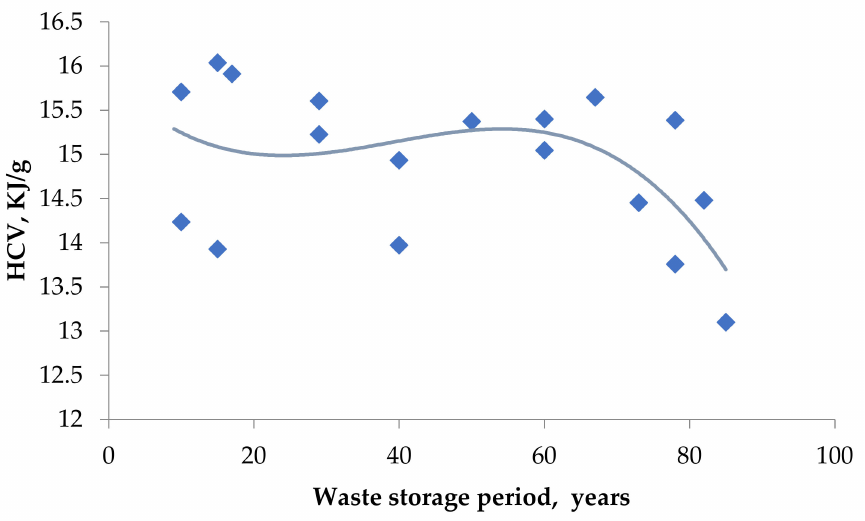
Figure 6. Changing of the BWW high calorific value. Table 4. Comparison of thermal properties of BWW samples with